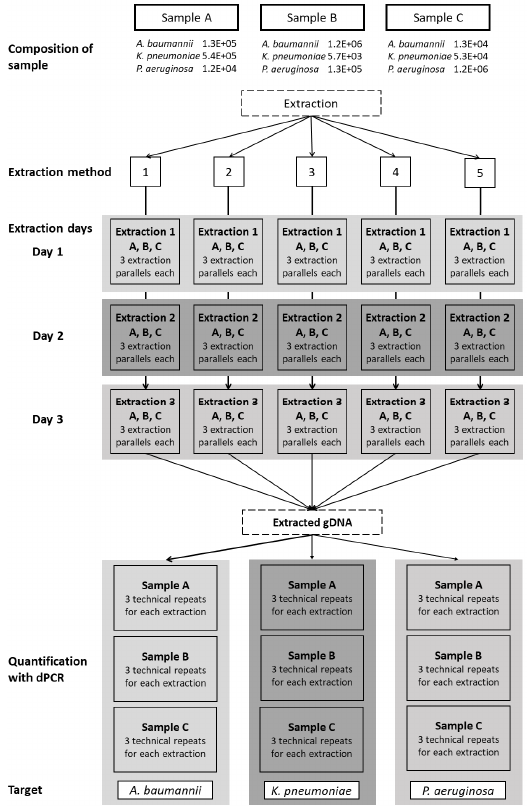
Figure 1. Schematic representation of the workflow. Three sputum samples, labeled A, B, and C, containing all three bacterial species in varying concentrations, were extracted using five extraction methods: 1, CTAB; 2, QIAamp DNA mini kit; 3, GXT NA extraction kit; 4, QuickPick genomic DNA extraction kit; 5, DNeasy UltraClean microbial kit. Each extraction was repeated on three different days, with three parallel extractions each day (three aliquots tested). The extracted genomic DNA was quantified using dPCR as three technical repeats for each of the target